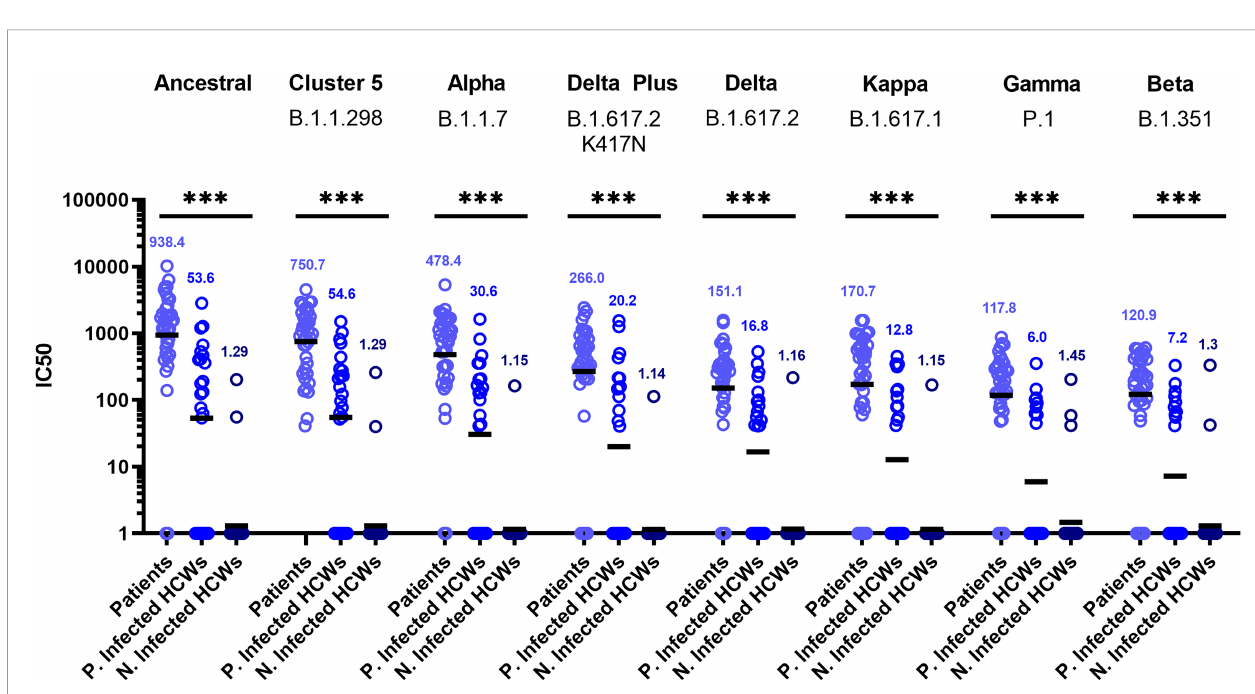
FIGURE 3 | Neutralisation titres split by well de fi ned patient and healthcare worker cohorts. When neutralisation titres were split into cohorts of patients, previously infected HCWs and non-infected HCWs, we observe higher neutralisation titres amongst patients across all variants. ANOVA tests were used for statistical analysis between the cohort groups (p = <0.001). Black lines denote geometric means. Geometric means are reported above the datasets. ***p=<0.001.